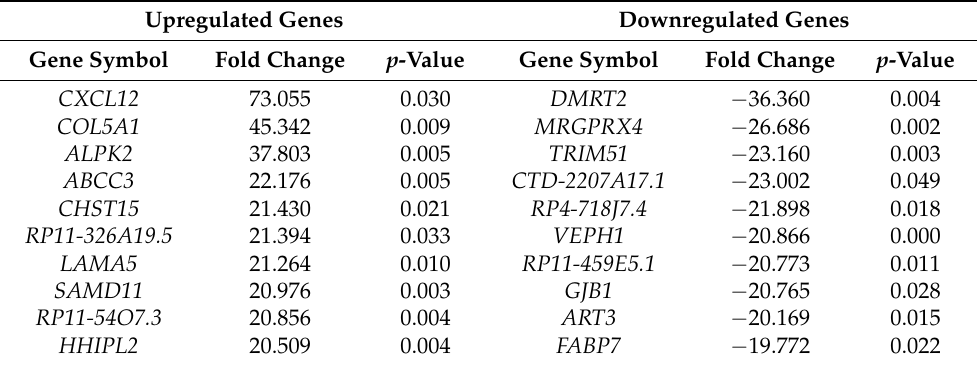
Table 2. Top 10 differentially expressed genes in resistant melanoma cell lines.